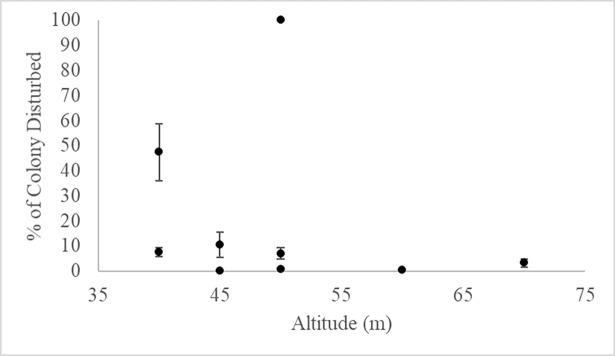
Crested terns disturbed by a drone at various altitudes.The percentage of crested terns (Thalasseus bergii) observed on the sand-bank to the southwest of Bare Sand Island, NT that took flight as a drone passed overhead at various altitudes. Although trials at altitudes lower than 40 m were possible ethical considerations and research permits prevented flyovers at lower altitudes.